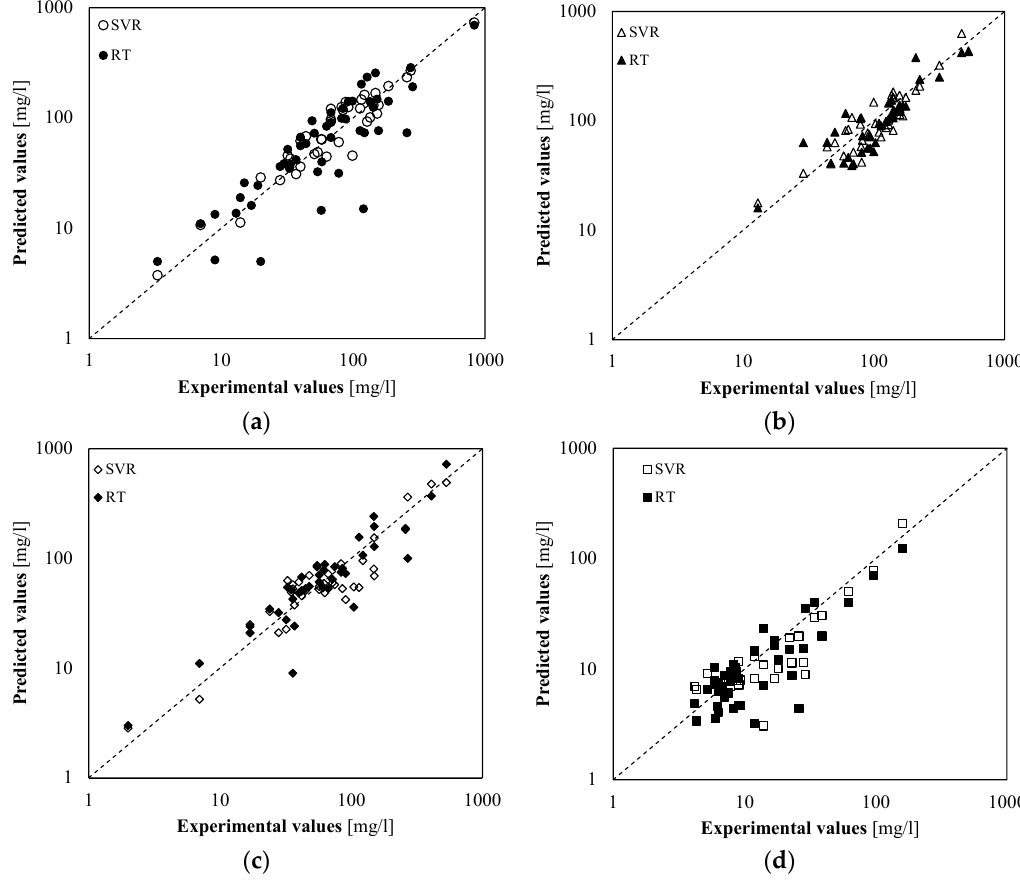
Figure 4. Comparison between predictions and experimental values. Logarithmic scale for both axes is used. ( a ) TSS; ( b ) TDS; ( c ) COD; ( d ) BOD 5 .